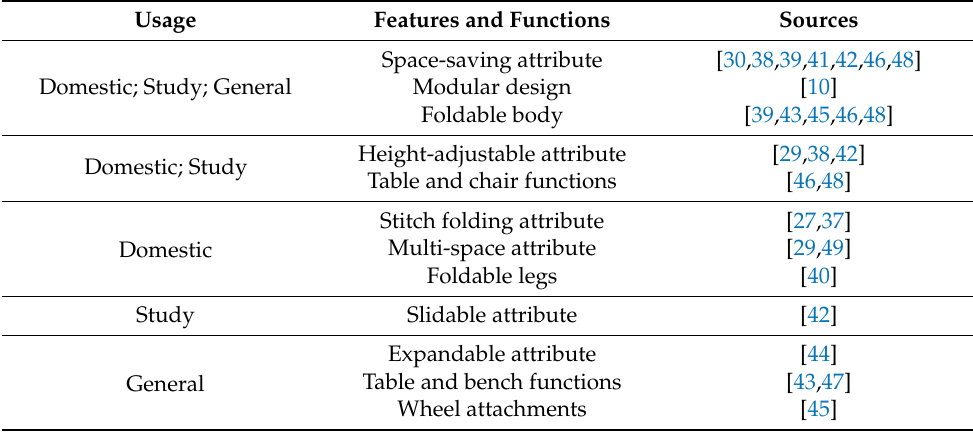
Table 1. Extracted features and functions from various sources.